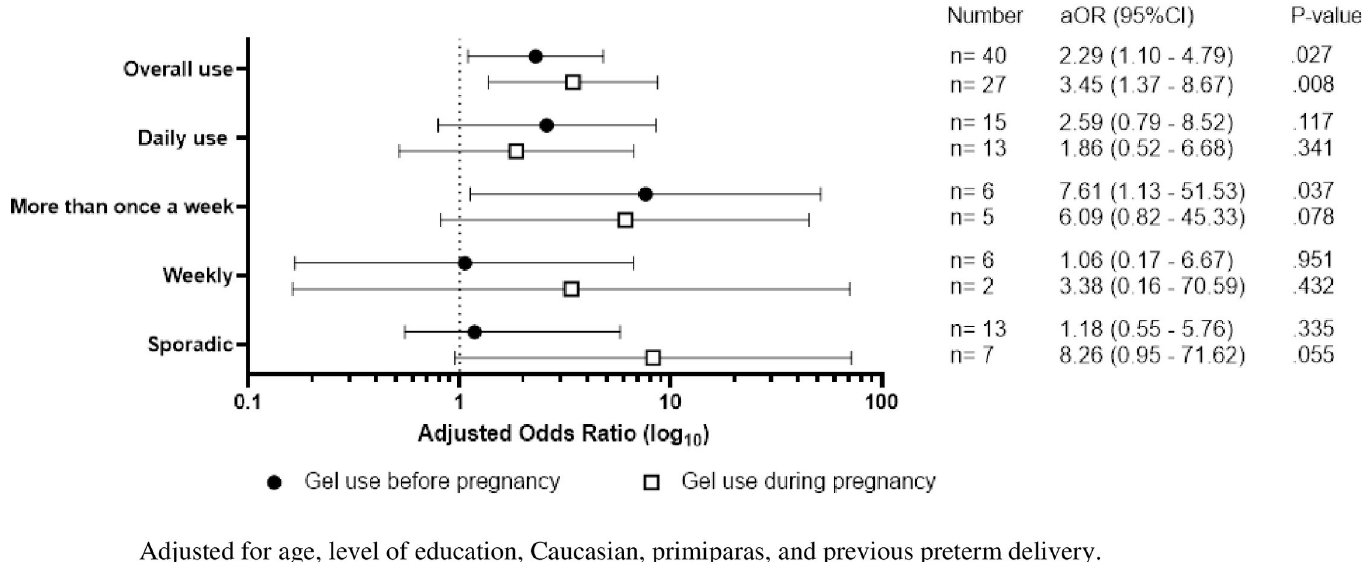
Fig 2. Adjusted odds ratio (AOR) and 95% confidence intervals (CI): Frequency of vaginal gel use and the risk of spontaneous preterm birth, versus no vaginal gel use.